Question: Sum up the contents of this chart in one sentence.
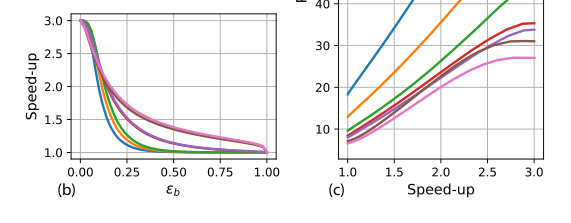
Answer: Dynamic multi-token perplexity (PPLd) for differ- ent models in the DynaMo suite. Effect of ϵb on (a) PPLd and (b) speed-up. (c) Plot of PPLd vs. speed-up.